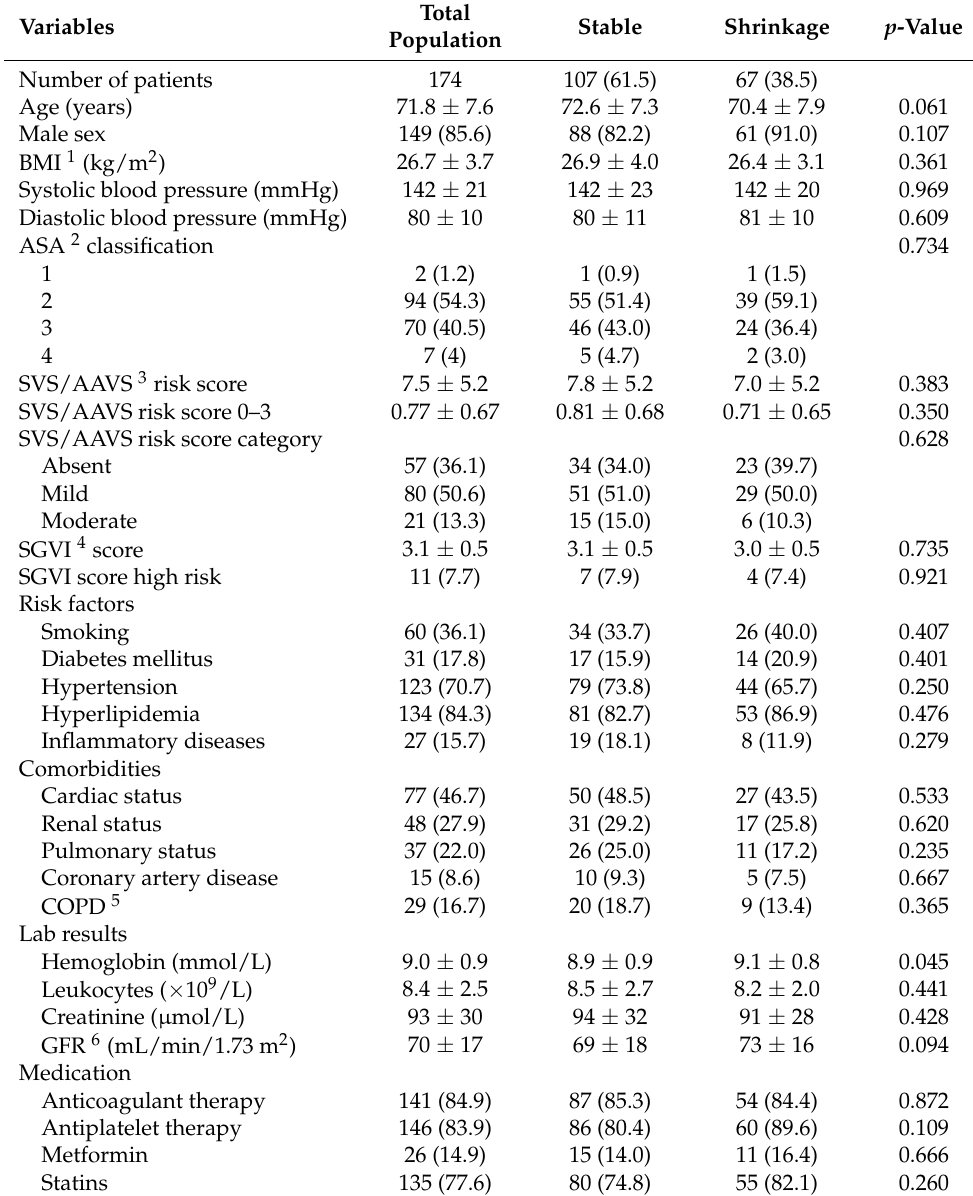
Table 1. Baseline demographics and clinical characteristics of the study population stratified by AAA